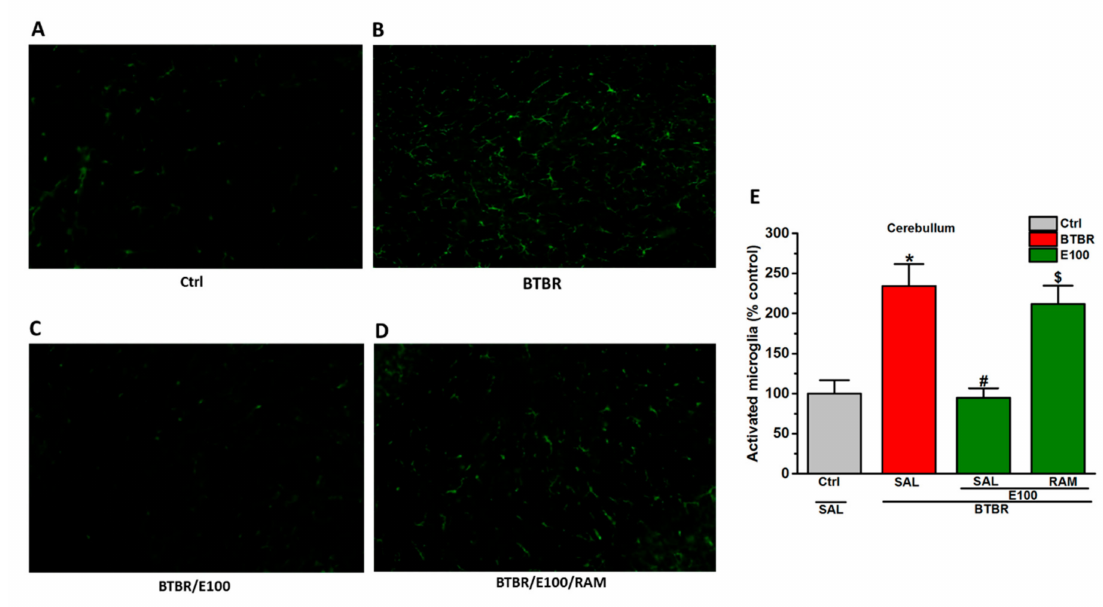
Figure 6. E100 decreased iba-1-positive microglial cells in cerebellum tissues of BTBR mice. ( A ) Immunofluorescent staining of cerebellar brain tissues with Iba-1 of BTBR mice; ( A – D ) Images show 20- µ M-thick sections of cerebellum of di ff erent groups; ( E ) Densitometric assessment of fluorescent intensity was carried out to quantify activated microglia by Image J. ( B , E ) Significant increase ( * p < 0.05) in the number of activated microglia was observed in cerebellum of BTBR mice compared to Ctrl mice. ( C , E ) E100 (5 mg / kg, i.p.) subchronic treatment significantly reduced ( # p < 0.05)